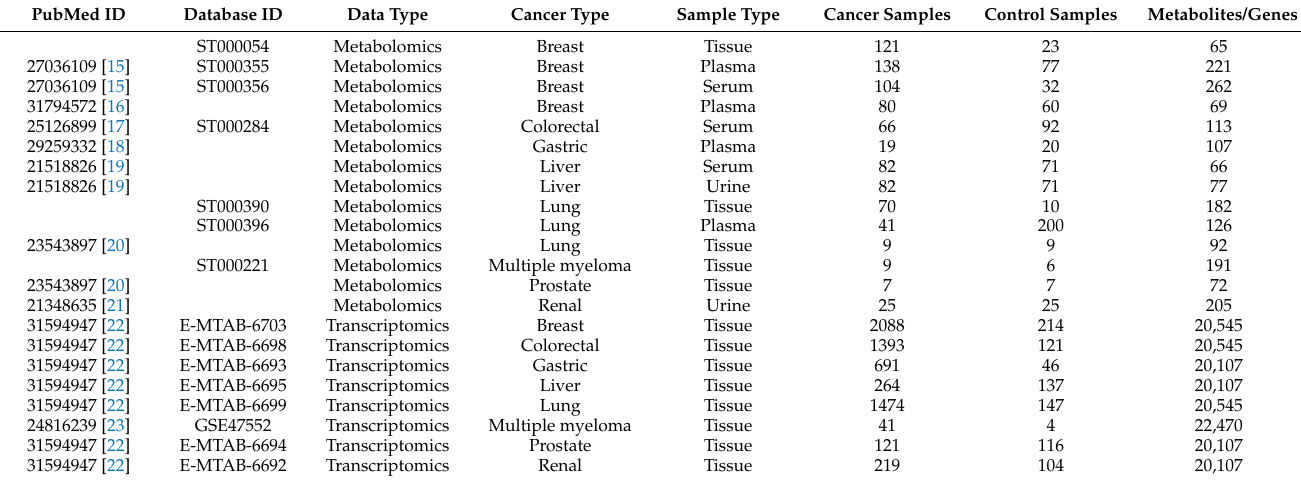
Table 1. A summary of all 14 metabolomics and 8 transcriptomics data sets across eight different cancer types and different sampling origins. Data sets that are not accompanied by a paper are provided with their corresponding database ID from either the Metabolomics Workbench or the Gene Expression Omnibus.